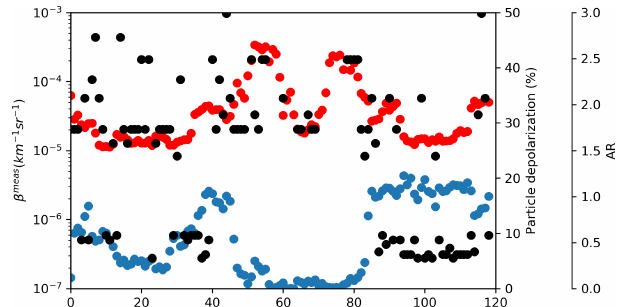
Figure 7. Sequences of β (red dots) and δ (blue dots) measured on a balloon flight on 9 December 2001, from Kiruna, Sweden. Each data point represents an average over 60s. Black dots represent the ARs providing the best match between the δ and those computed from concomitant measurements of